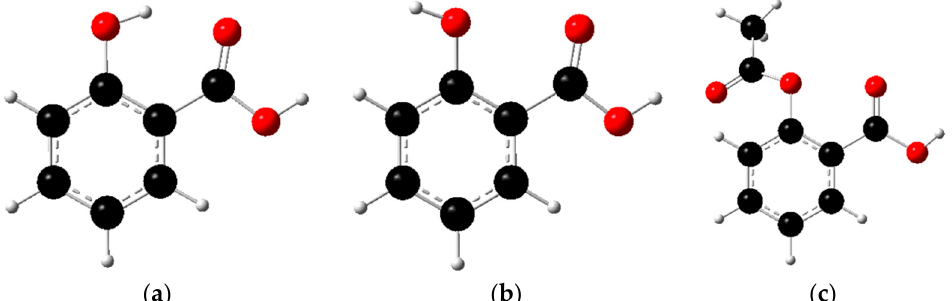
Figure 3. Two conformers of salicylic acid. Conformer ( a ) forms a hydrogen bond between a phenol OH and a COOH group (shown by the broken line), conformer ( b ) does not form a hydrogen bond, and conformer ( c ) is aspirin. The black, red, and white balls represent carbon, oxygen, and hydrogen atoms, respectively.